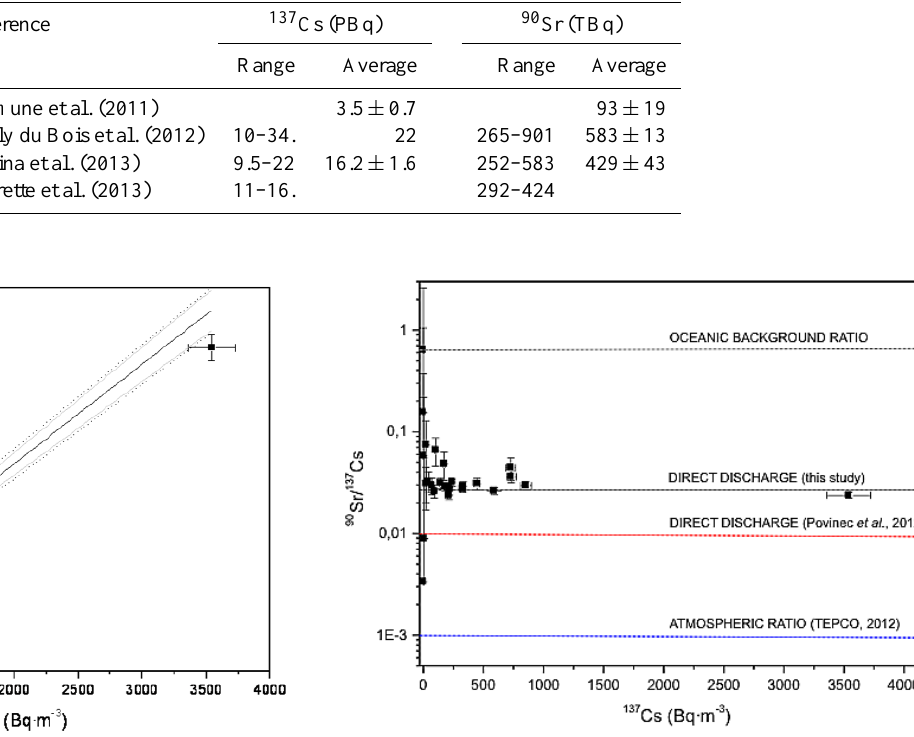
Fig. 8. The 90 Sr/ 137 Cs ratio as a function of 137 Cs specific activ- ities. The grey dashed line represents the oceanic background ratio decay corrected to 2011. Also shown are the 90 Sr/ 137 Cs ratios cor- responding to the oceanic background ratio, the direct discharges from Fukushima Dai-ichi and the atmospheric